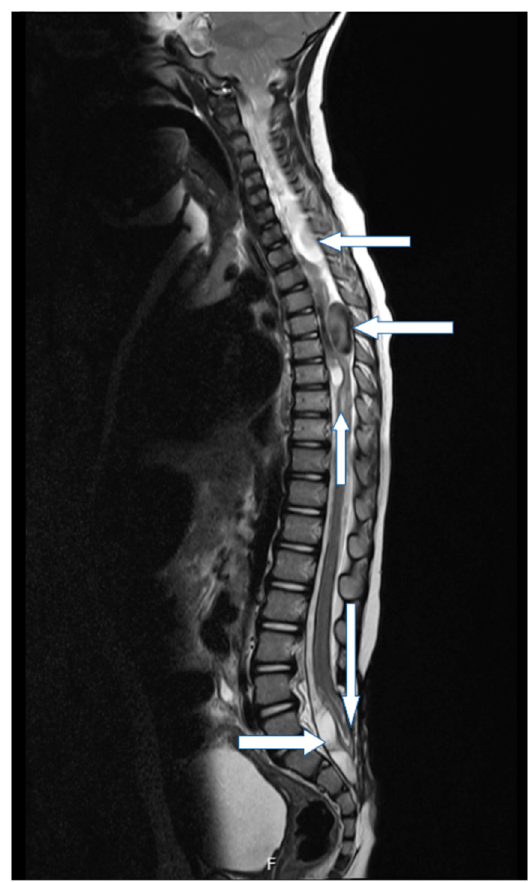
Figure 3. Sagittal MRI T2-weighted scan revealed spinal cysts in the thoracic (left arrows) and lumbar regions (right arrow), syringomyelia (up arrow) and tethered cord (down arrow).